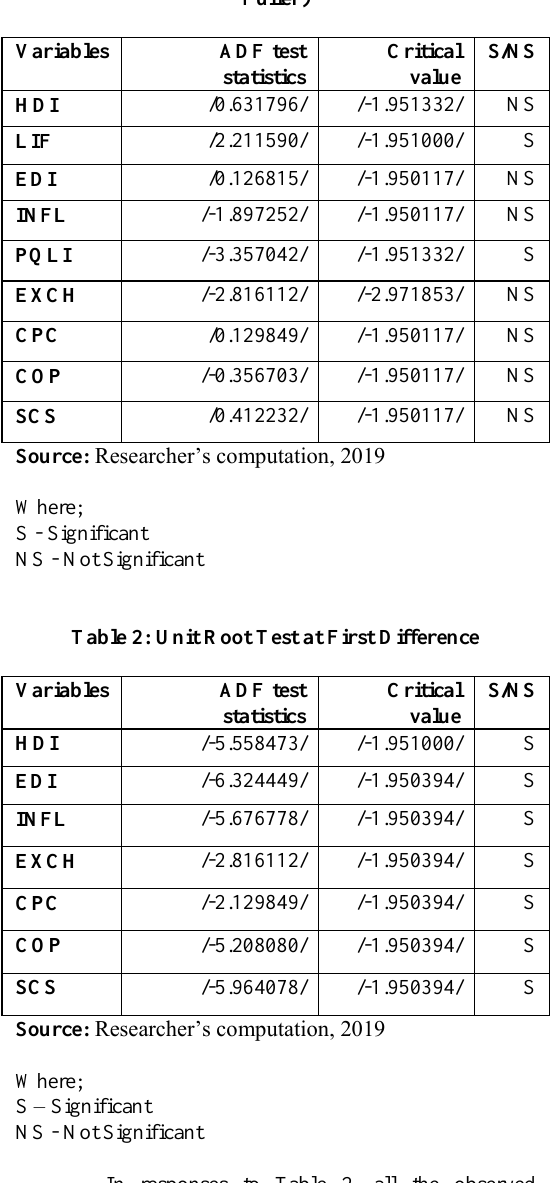
Table 1: Unit Root Test at Level (Augmented Dickey- Fuller)